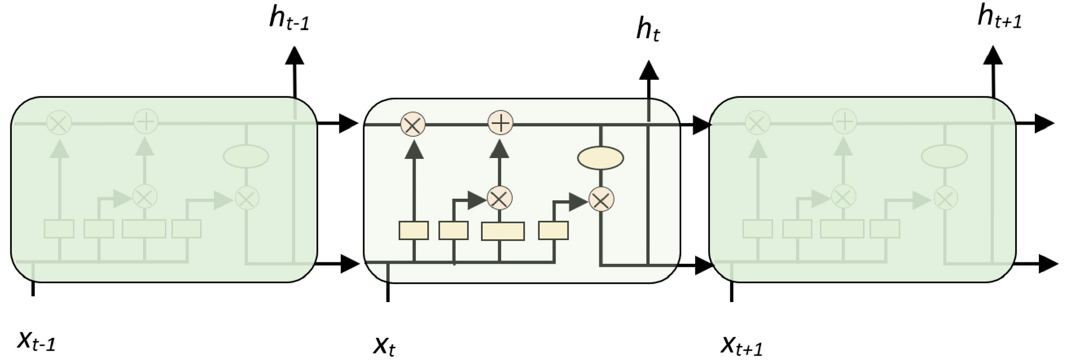
Figure 1. Structure of